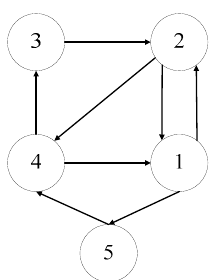
Figure 2. Topology network of intersection traffic lights in a grid.